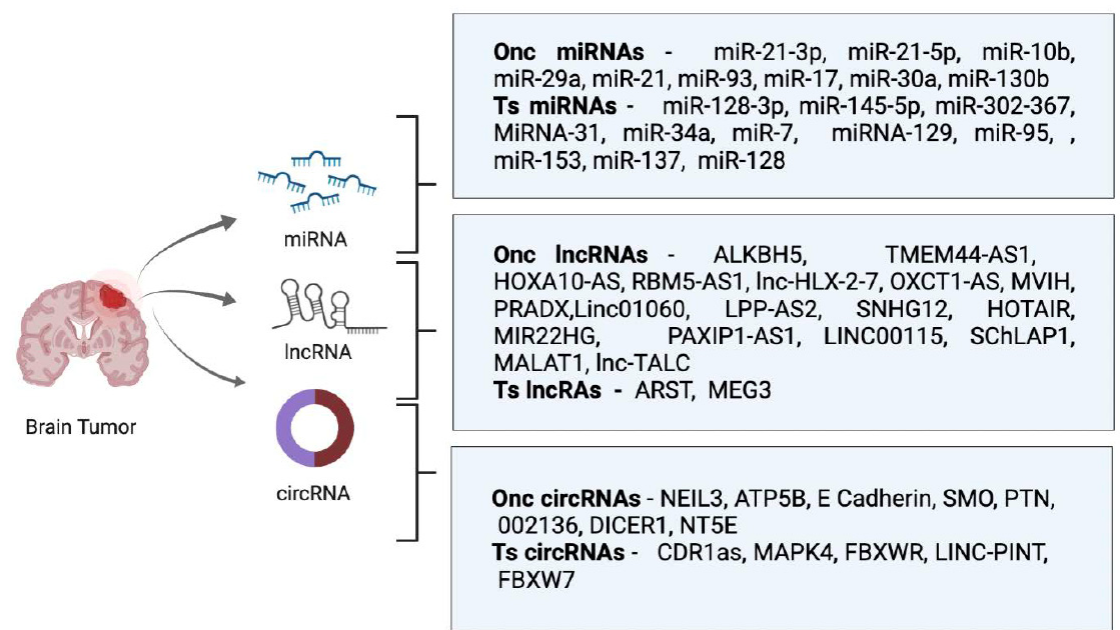
Figure 1. Oncogenic (Onc) and Tumor-suppressor (Ts) ncRNAs - MicroRNAs (miRNAs), long non-coding RNAs (lncRNAs) and circular RNAs (circRNAs) expressed in Glioma.